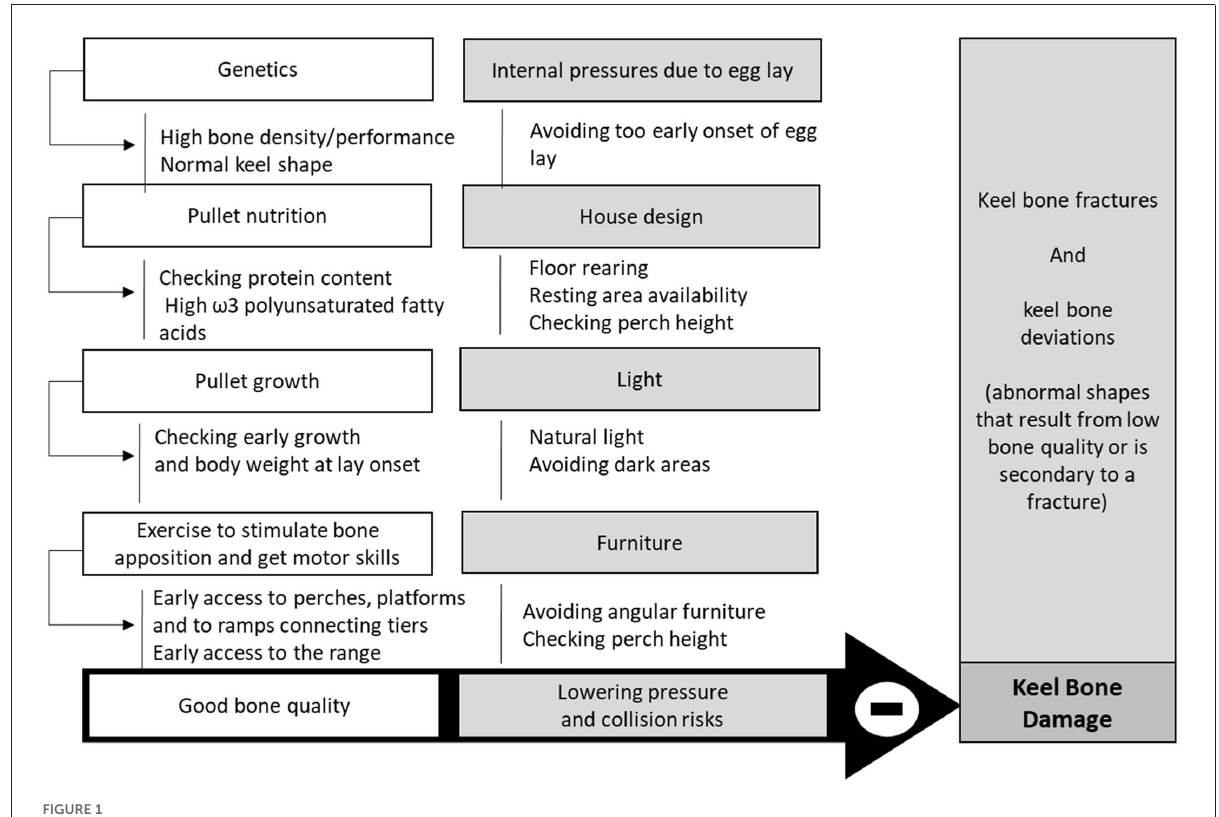
FIGURE1 Practices to prevent fractures and keel bone damage [Overview from